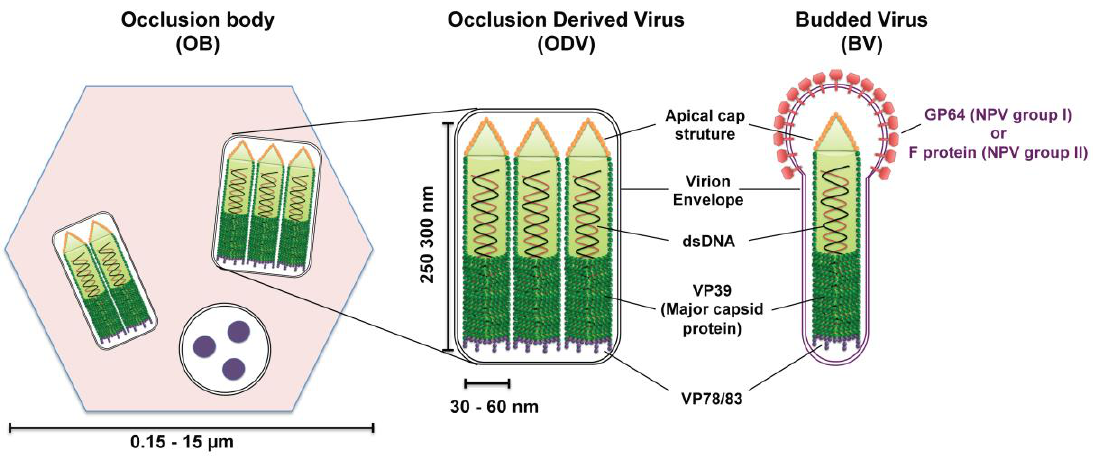
Figure 2. Schematic diagrams of the structure of baculovirus occlusion bodies (OB), occlusion-derived virion (ODV) and budded virion (BV). ODVs are embedded in